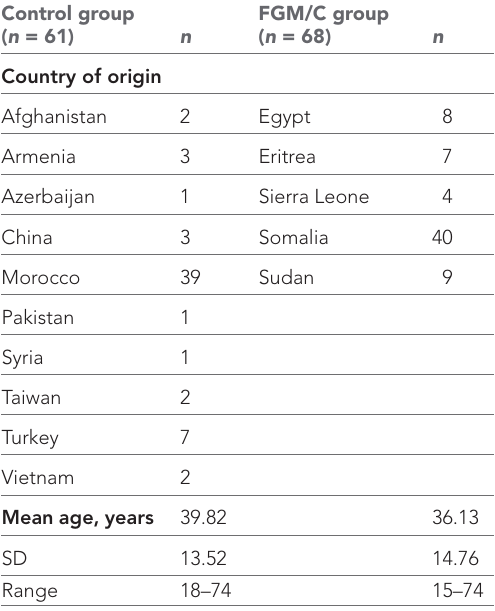
Table 1 Number of women in the FGM/C